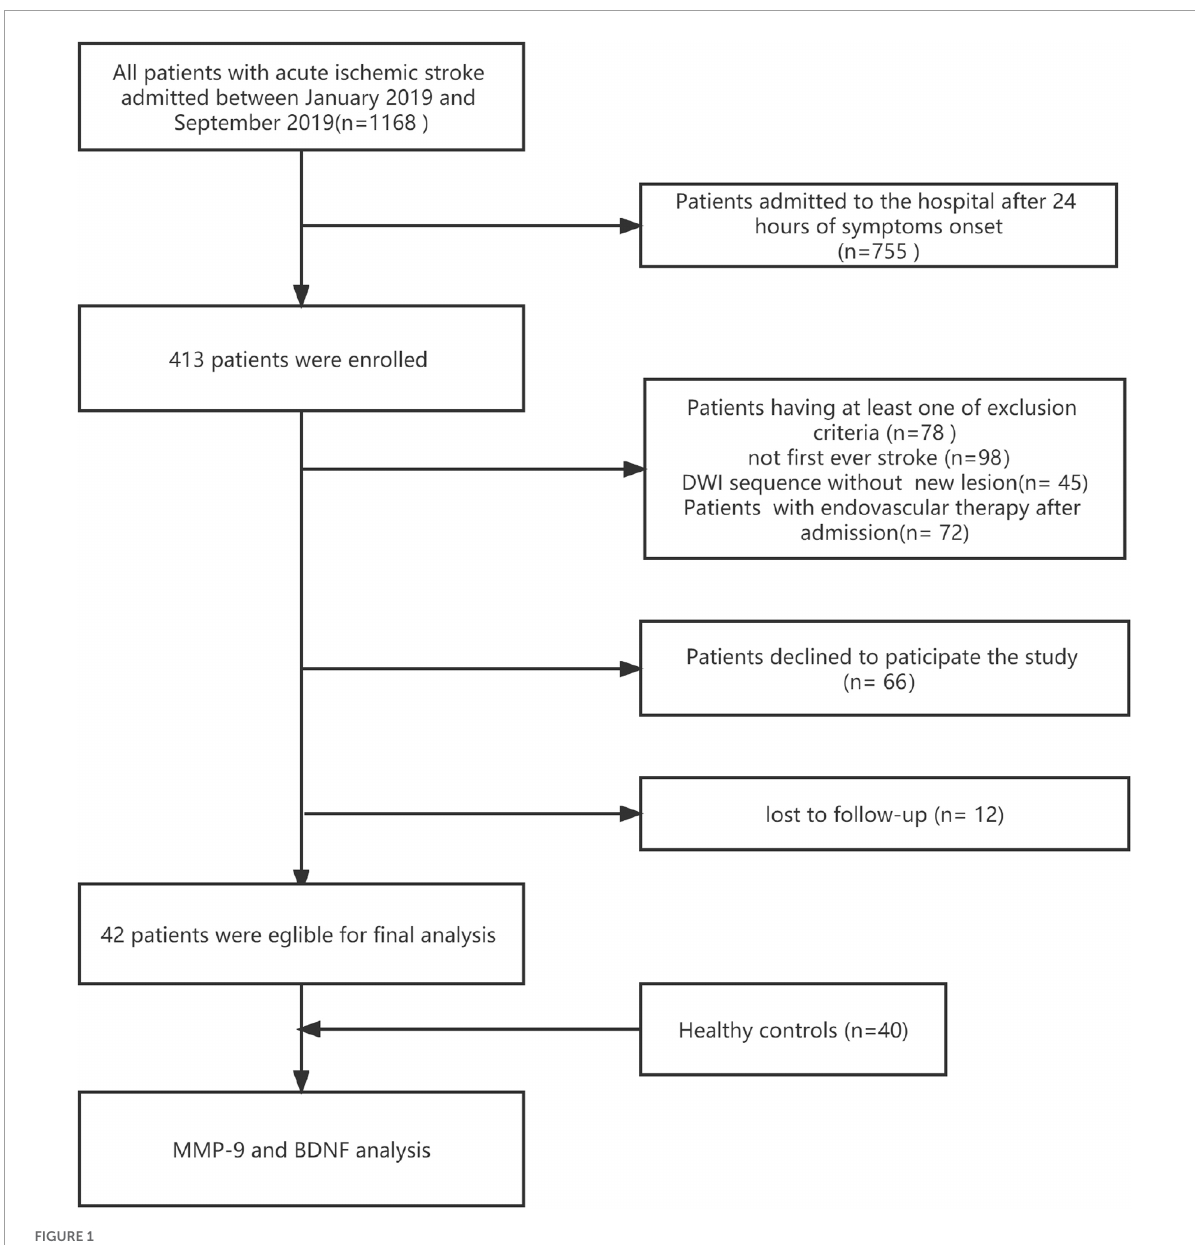
FIGURE1 The flow chart of the current study protocol is shown. DWI, diffusion weighted